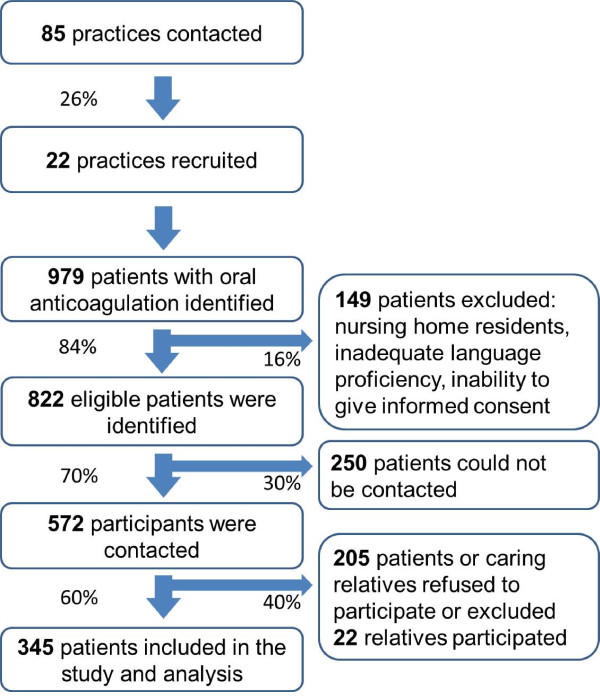
Recruitment flow.